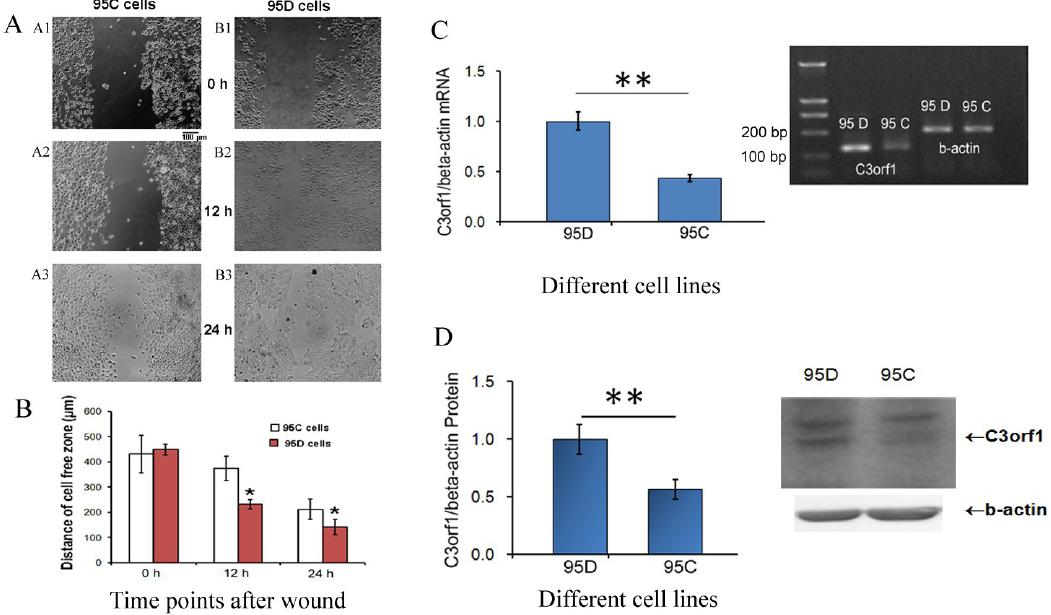
Figure 1. Expression of the C3orf1 gene is high in migratory 95D lung carcinoma cells. ( A ) Results of wound-healing assays in 95C and 95D cells. Panel A1–A3, representative images of scratch-wounded 95C cells at 0, 12, and 24 h. Panel B1–B3, representative images of scratch-wounded 95D cells at 0, 12, and 24 h. Scale bar = 100 µm; ( B ) Statistical results of wound healing assays in 95C and 95D cells. Measurements of the distance of wounded cell-free space at the indicated time points. Data are represented as mean ± SD; n = 3; * p < 0.05; ( C ) Results of real-time quantitative PCR measuring the relative c3orf1 mRNA level in lung carcinoma 95D and 95C cells. β-actin was used as an internal control. Data are represented as mean ± SD. The data were normalized ( i.e. , the average expression level of c3orf1 in 95D cells was set to 1, and the average expression level of c3orf1 in 95C cells was calculated in relation to this averaged value); n = 4, ** p < 0.01. The insert panel is a representative image of the semi-quantitative RT-PCR gel; and ( D ) Results of Western blotting analysis used to detect the relative C3orf1 protein level in lung carcinoma 95D and 95C cells. β-actin was used as the internal control. Data are represented as mean ± SD. The data were normalized as described in Figure 1C; n = 3, ** p < 0.01. The insert panel shows representative images of Western blotting